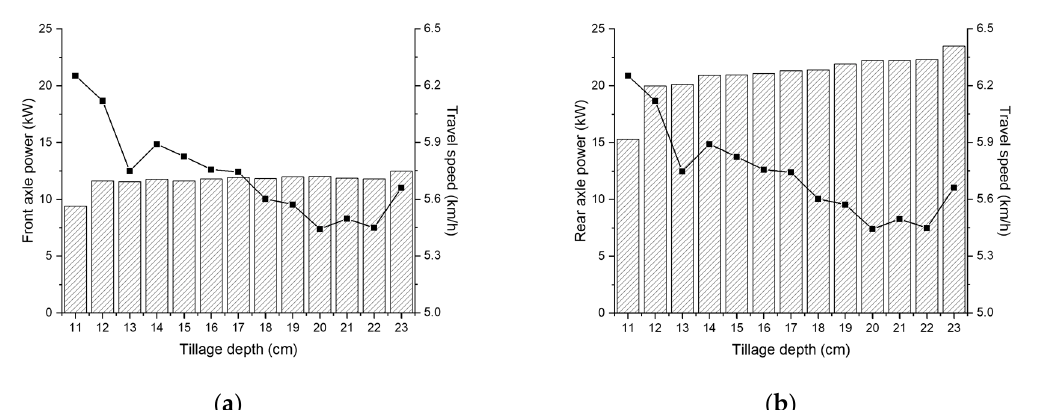
Figure 12. Overall mean power requirements of wheel axle according to tillage depth: ( a ) front axle, and ( b ) rear axle.